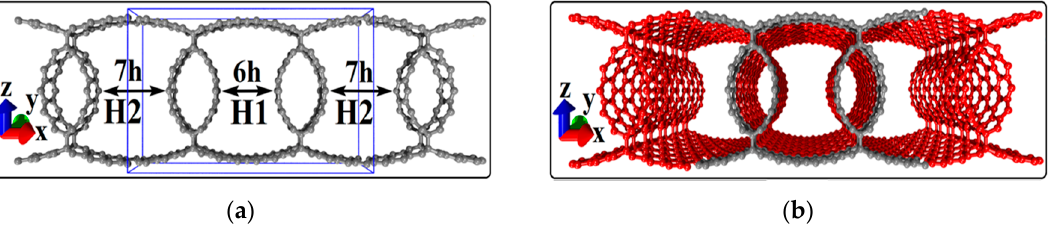
Figure 1. Topological models of graphene / single-wall carbon nanotube (SWCNT) composite films based on SWCNTs (10,0): ( a ) extended supercell of the composite film; ( b ) fragment of the composite film. The atoms of the supercell are highlighted in gray; the fragment of the composite film obtained by translating a supercell along the X and Y axes is highlighted in red.